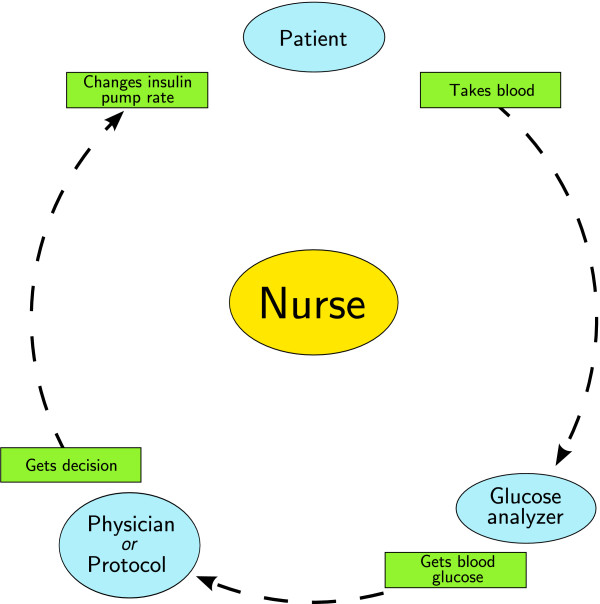
Glucose control cycle. Nurse-driven glucose control consists of the repetitive execution of the cycle depicted in this figure. First, the nurse acquires blood from the patients and gets the glucose level. A protocol or doctor then decides what action should be taken (in most cases a change of the rate of the insulin pump), and subsequently this action is performed at the bedside by the nurse.